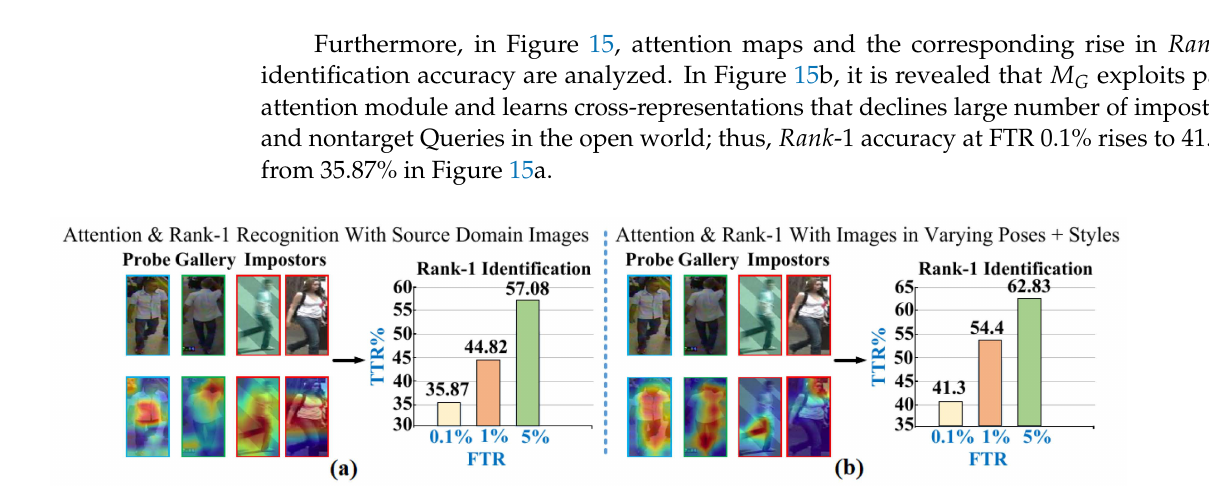
Figure 15. Rank-1 Result Comparison on VIPeR & GRID for ( a ) G.Sc. vs. RGB ( b ) Sk. vs.